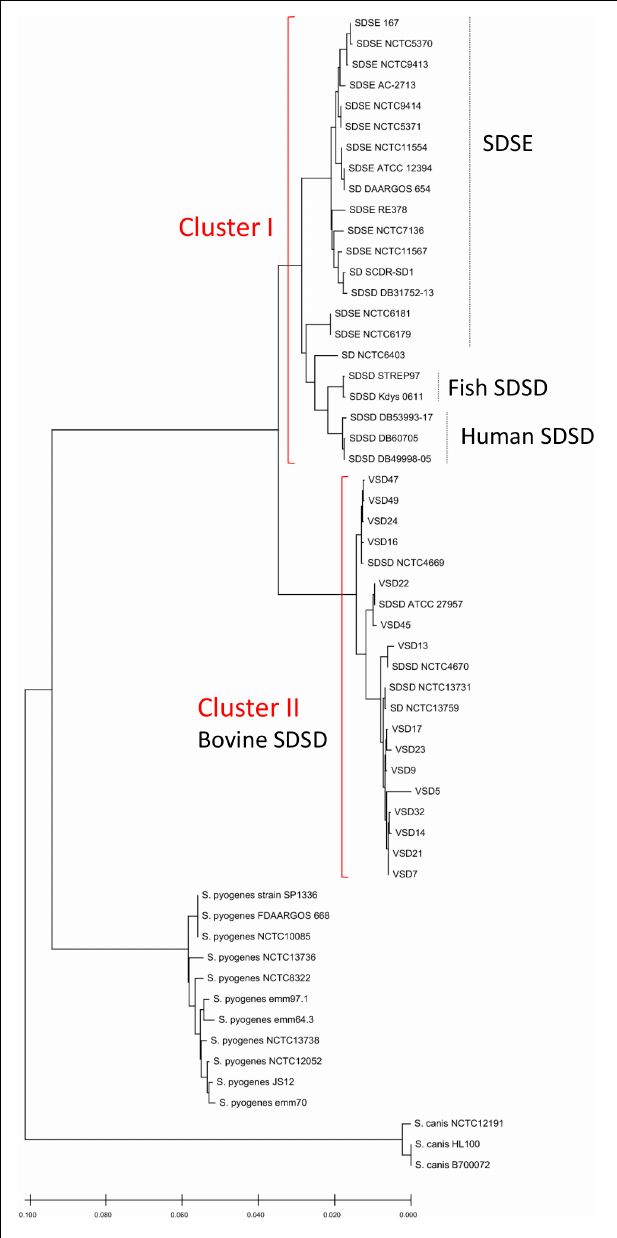
FIGURE 1 | Phylogenetic analysis based on concatenated sequences of seven housekeeping genes ( gki , gtr , murI , mutS , recP , xpt , and atoB ) showing the position of the 15 bovine SDSD isolates and sequences of strains available in the National Center for Biotechnology Information (NCBI) database, including SDSD strains ( n = 12), SDSE strains ( n = 15), Streptococcus pyogenes strains ( n = 11), Streptococcus canis strains ( n = 3). VSD, Vet S. dysgalactiae subsp. dysgalactiae . Bovine SDSD isolates: ATCC 27957; NCTC13731; NCTC4669; NCTC4670 and VSDs. Human SDSD strains: DB31752-13; DB49998-05; DB60705-15, and DB53993-17. Fish SDSD strain: SDSD Kdys0611. SDSE, S. dysgalactiae subsp. equisimilis . The phylogenetic relationships were inferred using the minimum evolution method, and phylogenetic distances were estimated using the maximum composite likelihood method using the MEGA (Kumar et al., 2018). The tree is drawn to scale, with branch lengths in the same units as those of the evolutionary distances used to infer the phylogenetic